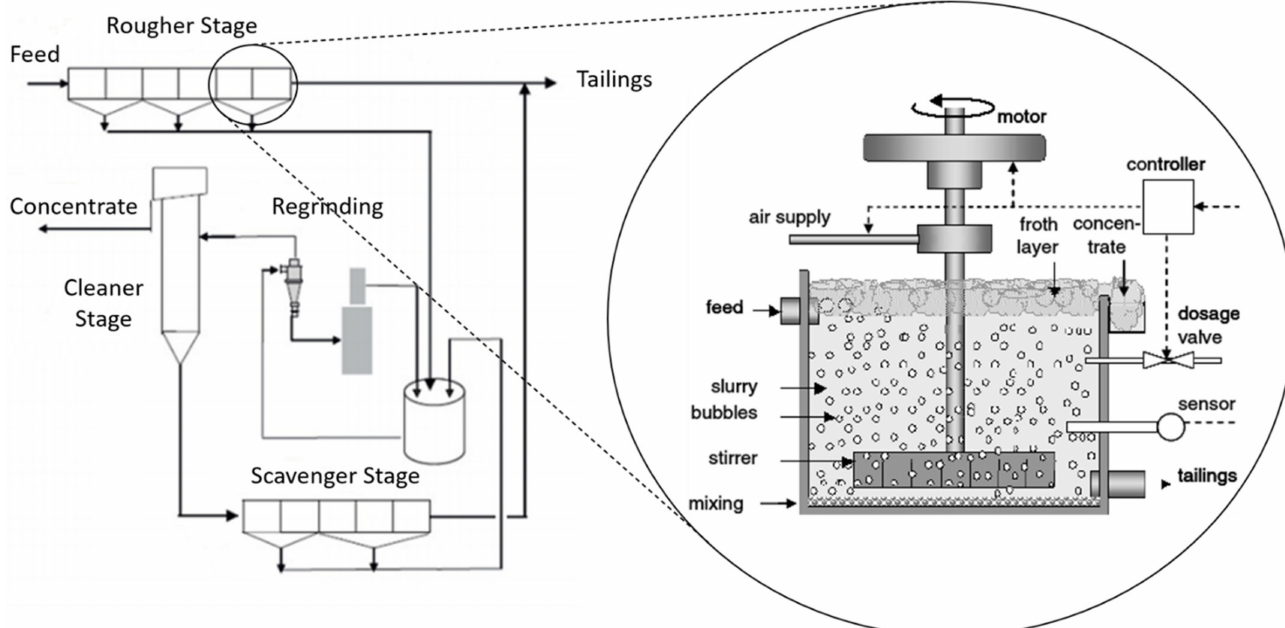
Figure 1. Superstructure of an RCS flotation circuit and rougher flotation